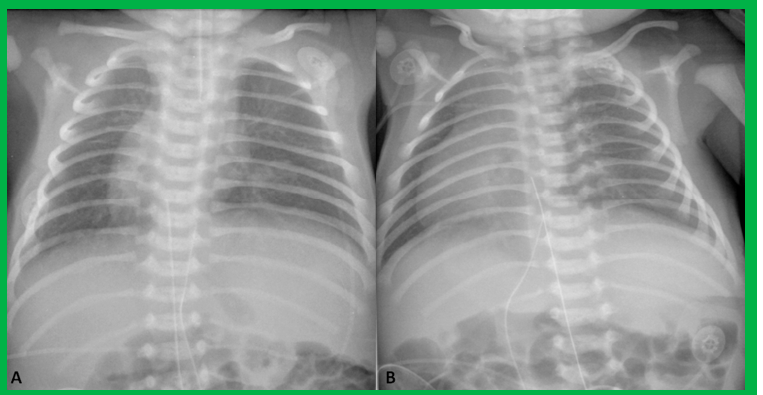
Figure 9. Chest roentgenograms of two babies with dextrocardia demonstrating liver across the entire abdomen. These babies were later diagnosed with asplenia syndrome. Umbilical venous and arterial catheters (not labeled) are seen in both ( A ) and ( B ).